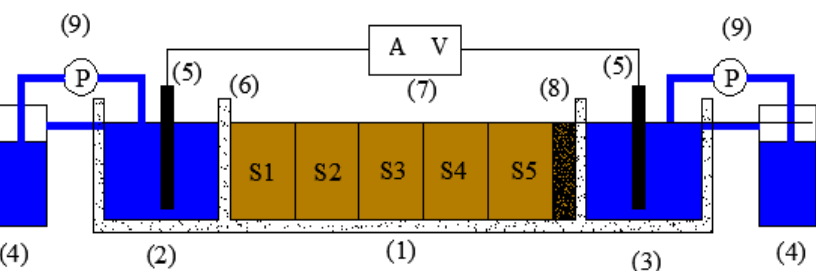
Figure 1. A schematic diagram of the experimental reactor for electrokinetic remediation: (1) Soil chamber, (2) Anode chamber, (3) Cathode chamber, (4) Electrolyte solution reservoir, (5) Graphite electrode, (6) Plexiglass and filter paper, (7) DC power supply, (8) PRB (9) Peristaltic pump.